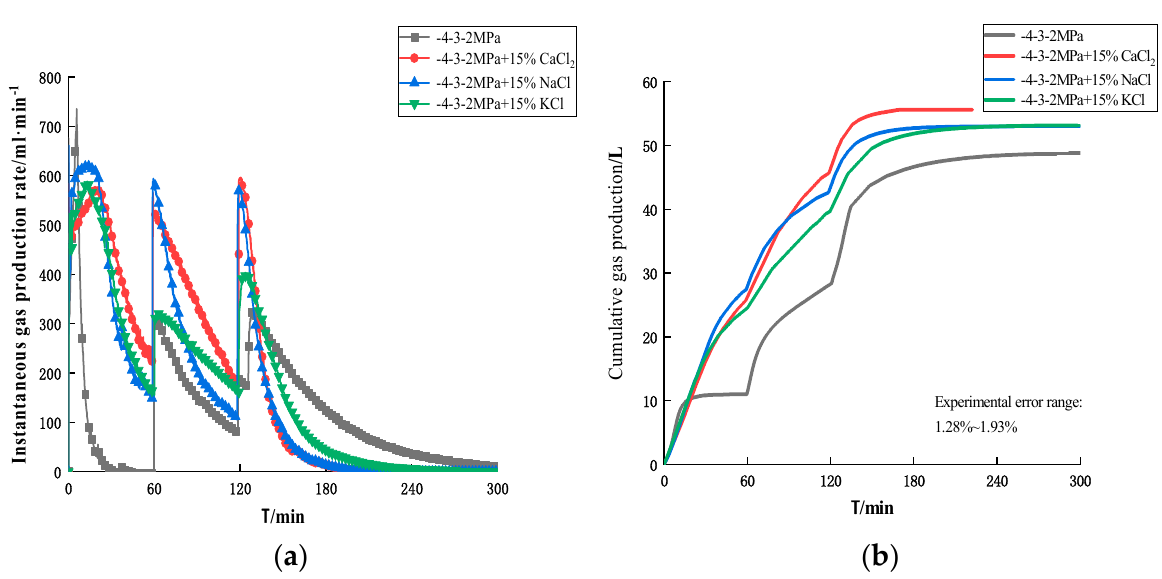
Table 2. Relevant experimental parameters of gas hydrate depressurization and salt injection pro- duction.